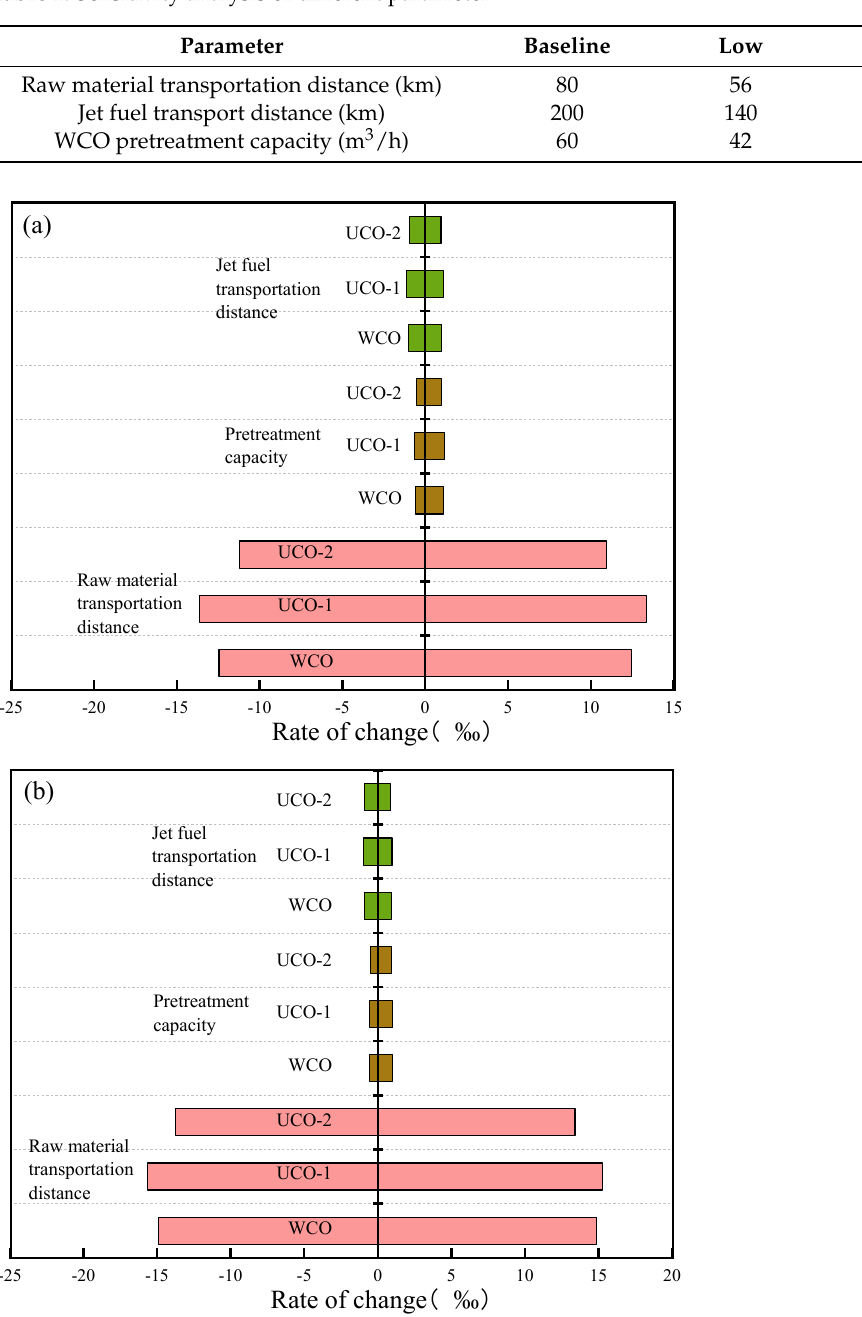
Table 1. Sensitivity analysis of different parameter.